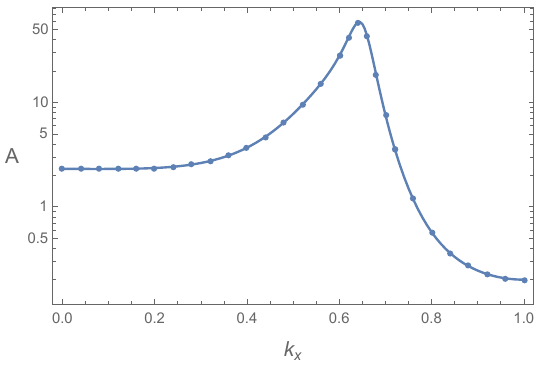
Figure 20 . The MDF along the k x -axis for a 0 = 0 : 5, ! = 10 (cid:0) 6 , q = 2 and T = 0 : 01426. The curve is computed by choosing N z = N x = 21, and the dots are obtained by N z = N x = 51 (the grid size for the background